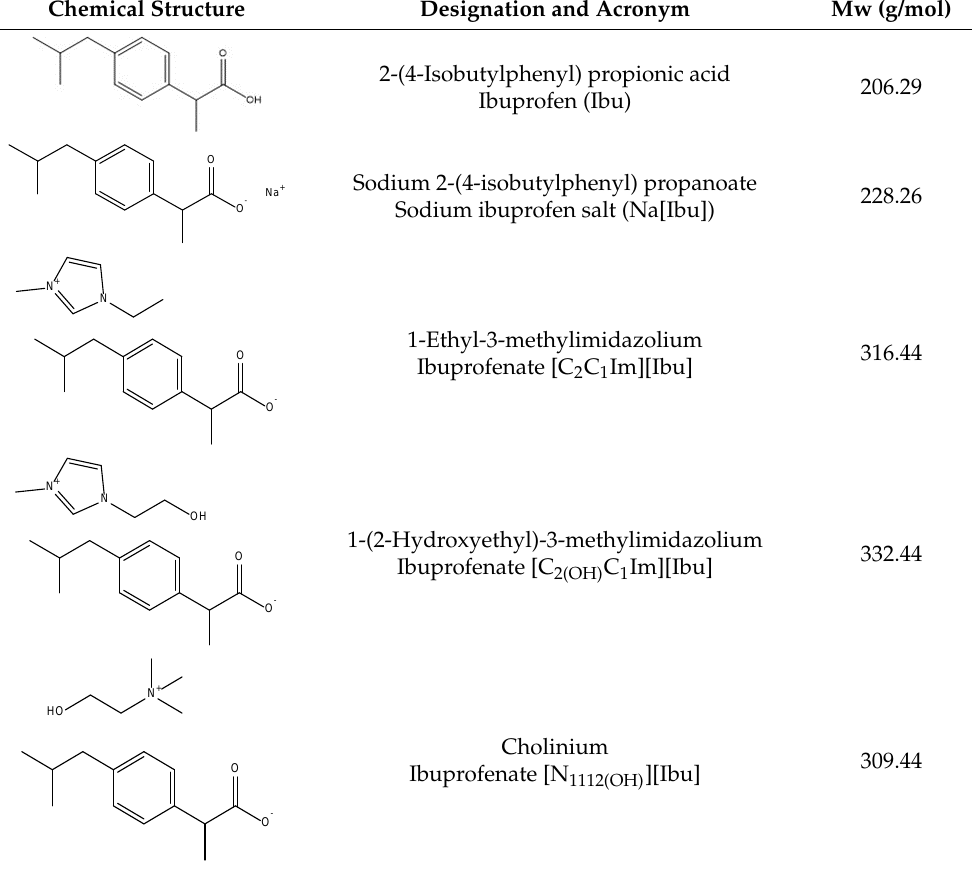
Table 1. Chemical structures and respective acronyms and molecular weights of ibuprofen, sodium ibuprofen and the ibuprofen-based API-ILs.